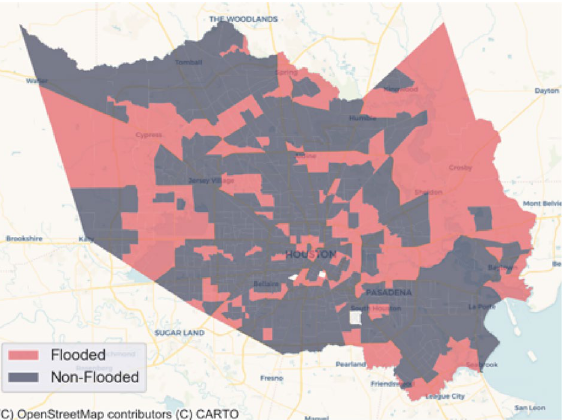
Figure 8. Map of the flooded and non-flooded census tracts in Harris County based on the flood inundation map of Hurricane Harvey produced by